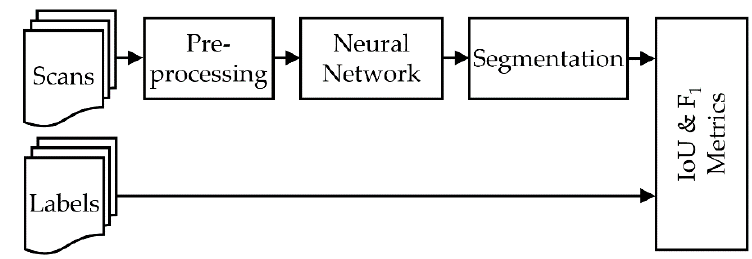
Figure 11. ( a ) Excerpt of a rolling element. Defects were manually highlighted with bounding boxes. ( b ) Segmentation image of the neural network before post ‐ processing, displayed with viridis color scheme.